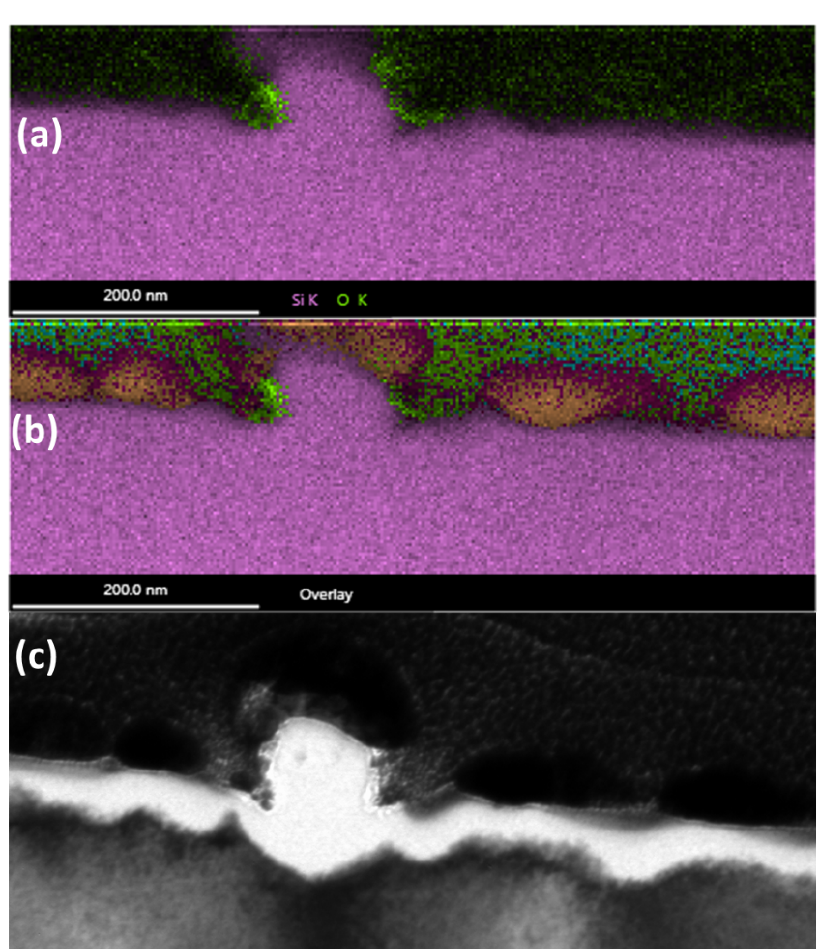
Figure 13. Spatially resolved Energy-dispersive X-ray spectroscopy (EDX) of an NSC outgrowth combining elemental signals. ( a ) silicon and oxygen peaks plotted; ( b ) Silicon, Copper, Gallium, Platinum, Gold, Carbon, and Oxygen are all plotted together, as color coded by the words used to describe them here; ( c ) cross-sectional TEM of the area which has undergone EDX in ( a , b ). Figure 13 clearly indicates that the NSC outgrowth is not made of a